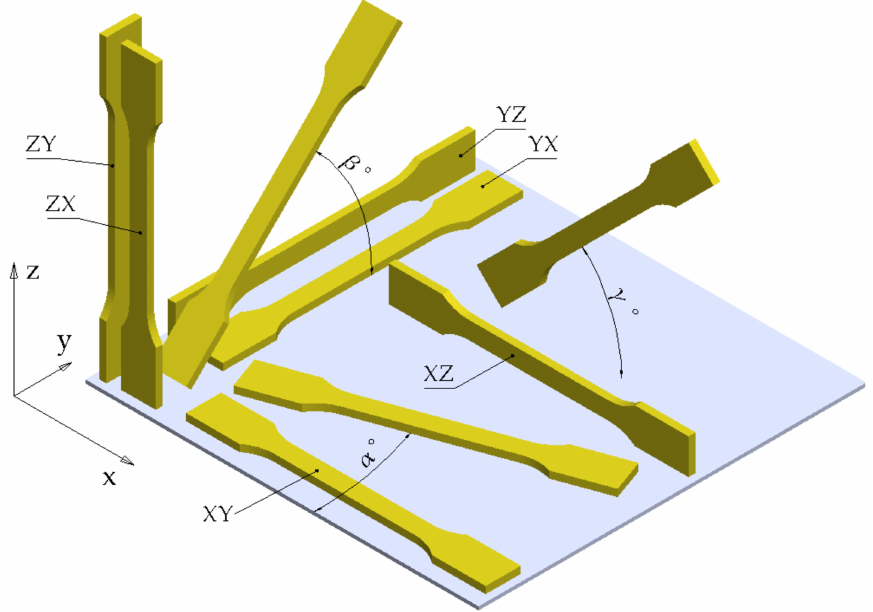
Figure 2. Notation of different build